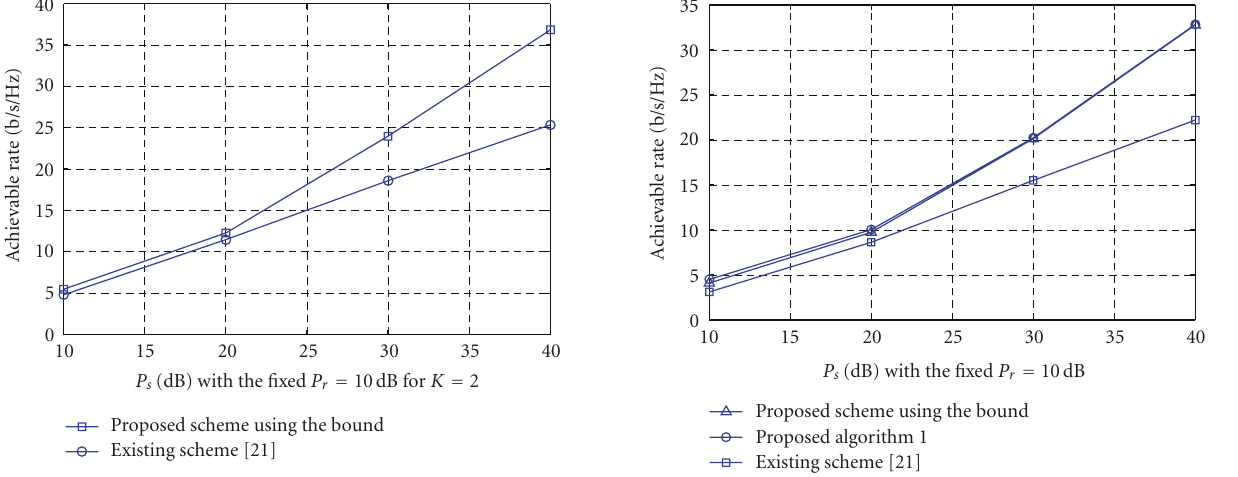
Figure 5: Achievable rate comparison at di ff erent values of subtotal power of sources when K =